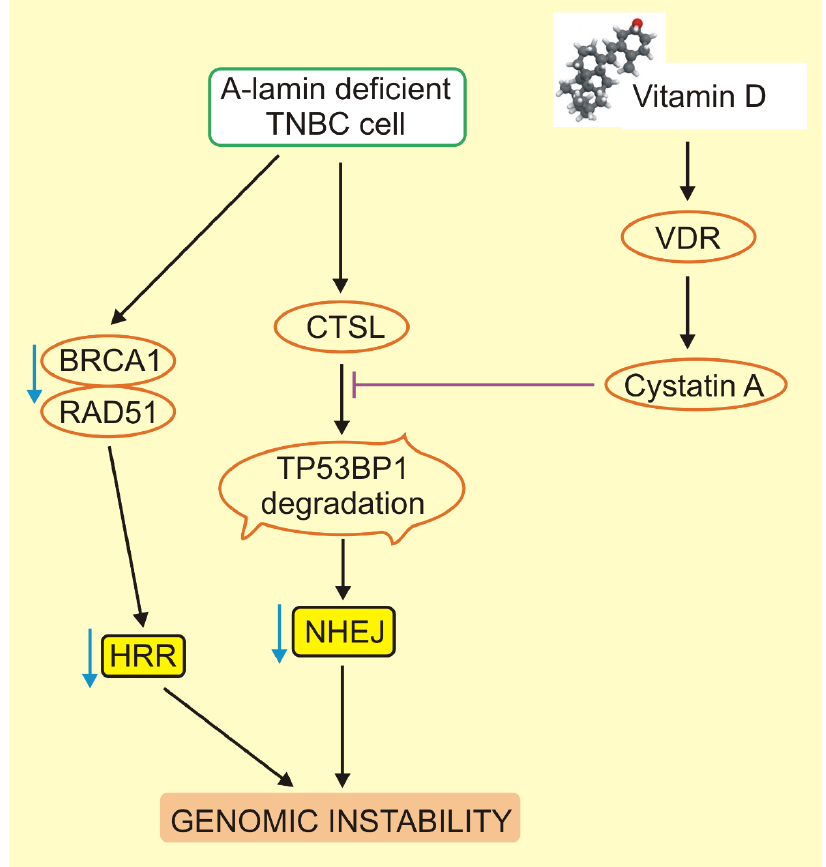
Figure 2. Vitamin D may ameliorate defects in DNA repair associated with the loss of A-type lamins